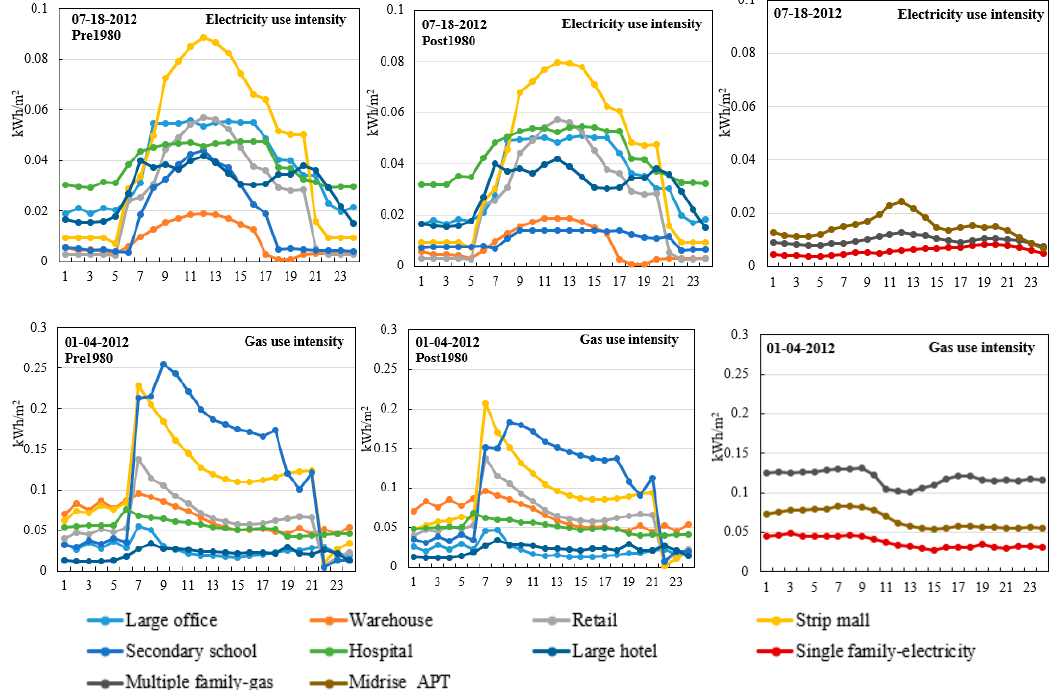
Figure 11. Hourly energy-use intensity (major building types) in Manhattan, NYC.